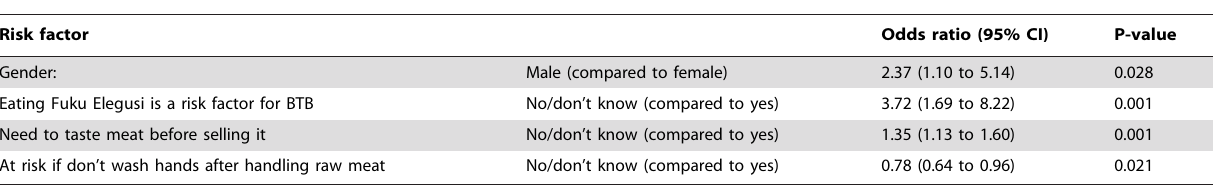
Table 8. Results of logistic regression analysis